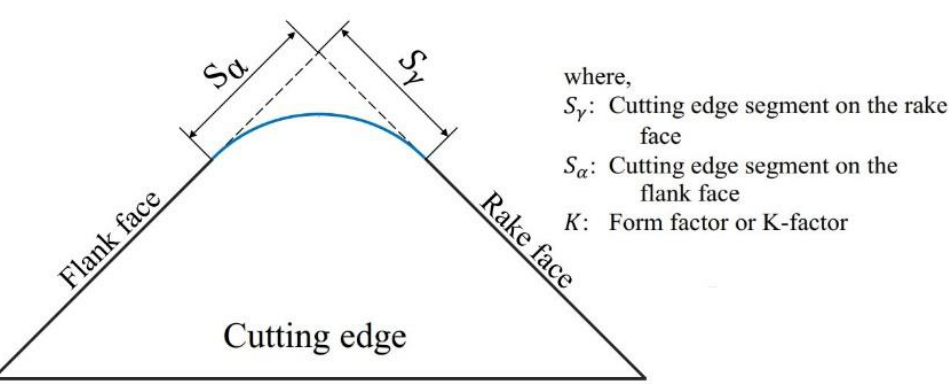
Figure 1. Parameters used in edge geometry determination [8].